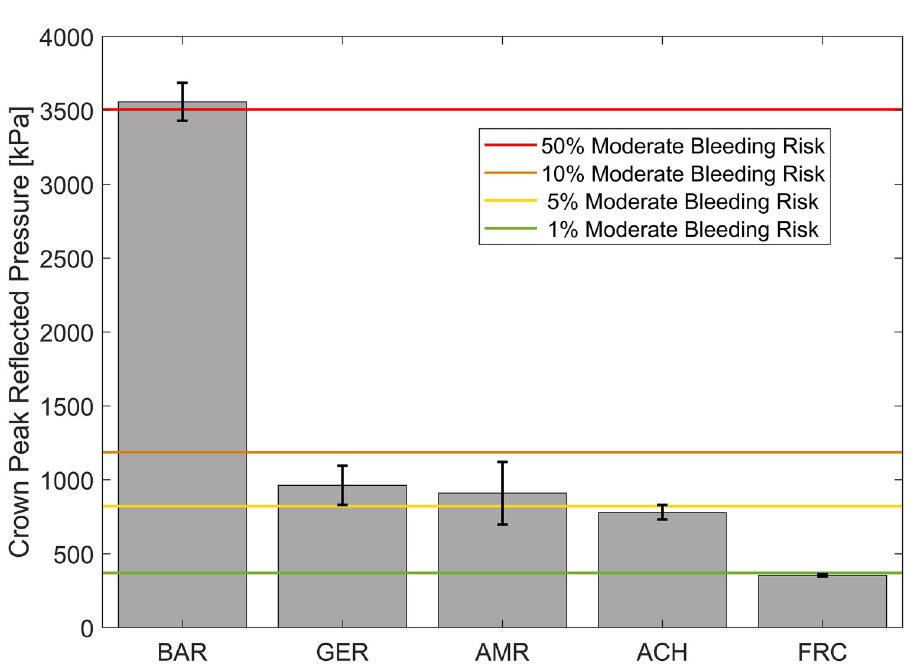
Fig 10. Risk reduction for moderate bleeding in helmeted cases. Mean peak pressure measured at the crown of the head for moderate severity blasts (Table 4), including standard error indicated on the bars. For approximately a 50% moderate bleeding risk in the bare head scenario, moderate bleeding risks for all helmets is more than 5x lower for the same testing